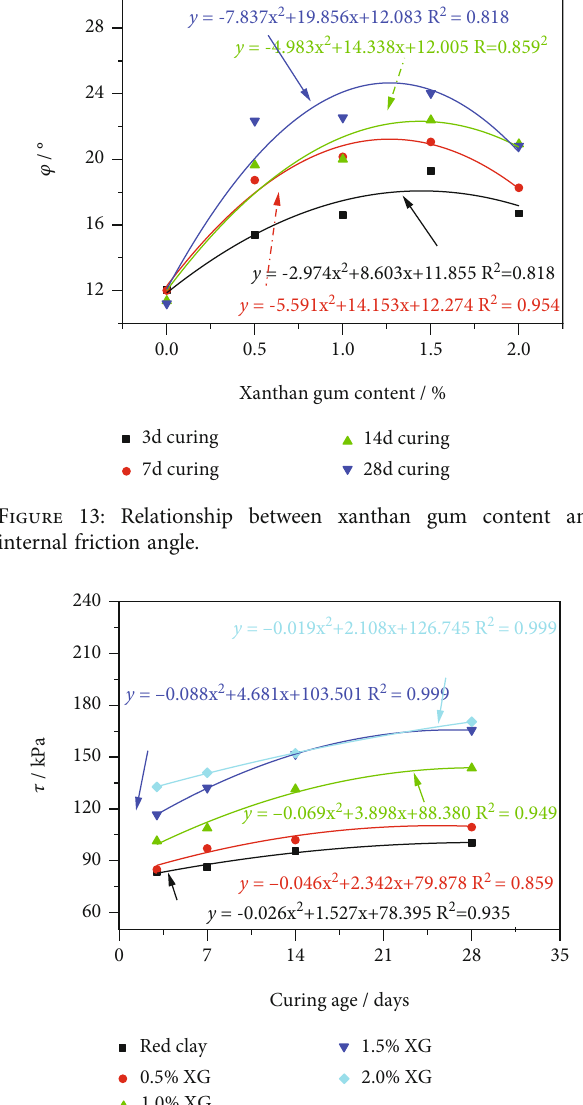
Table 5: Fitting results of shear strength index.